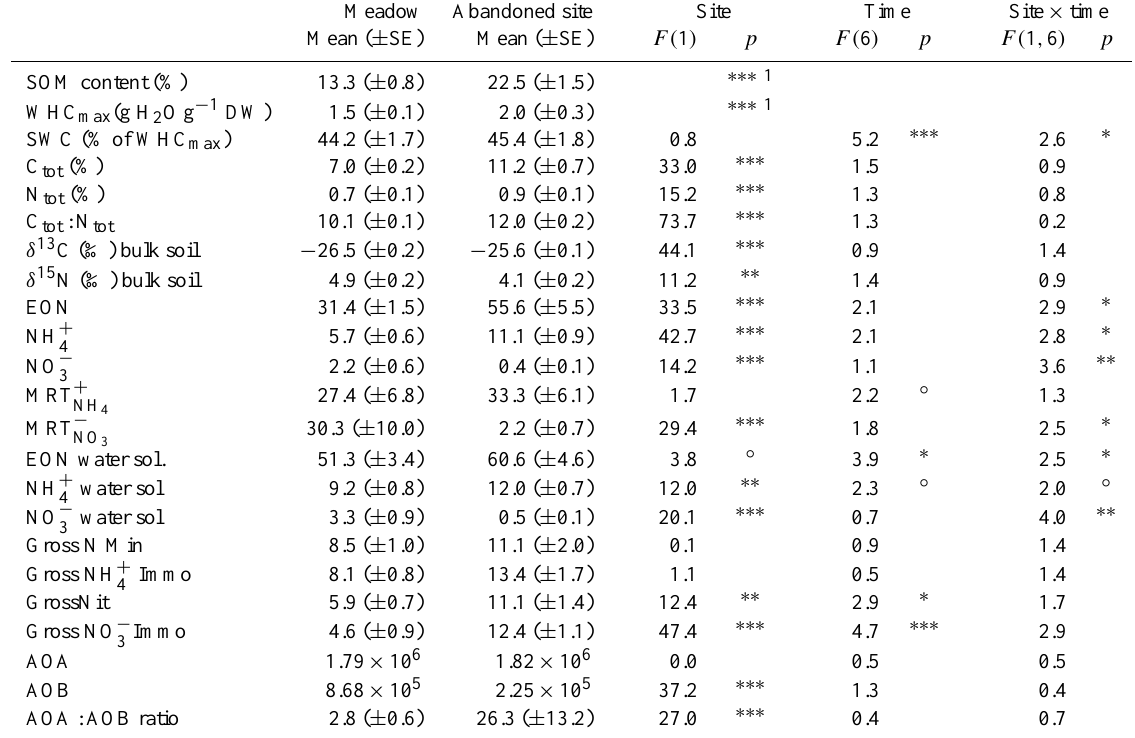
Table 1. Soil parameters, nitrogen pools (µg Ng − 1 DW soil and in µg Ng − 1 soil water: water sol.), nitrogen turnover rates (µg Ng − 1 DW soil d − 1 ), mean residence times (MRT) of ammonium and nitrate ( h ), as well as microbial abundances (gene copies g − 1 DW soil) in soils of the meadow and the abandoned site ( n = 28; means ± standard error). Effects of site and sampling time, as well as their interaction were assessed by repeated-measures ANOVA for non-drought-treated controls. Asterisks mark levels of significance: ◦ < 0 . 1; ∗ = p < 0 . 05; ∗∗ p < 0 . 01; ∗∗ p < 0 . 001 (differences between sites for WHC max ; n = 16, and SOM content n = 12 were analysed by t -tests). Meadow Abandoned site Site